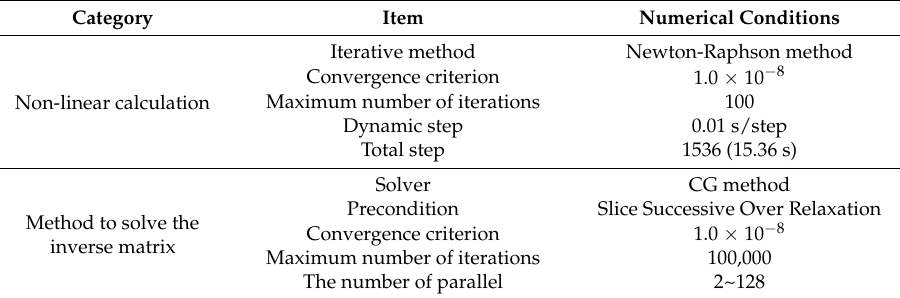
( b ) Figure 13. Shear strain distribution of ZX direction (15.36 s) in ( a ) the original model and ( b ) the proposed model. The excess pore water pressure ratio distribution at the final time step is shown in Figure 14. The proposed model produced slightly higher excess pore pressure than the original model, but the distributions of both models were relatively very similar. For both models, the maximum value of the excess pore water pressure ratio exceeded 0.5. ( a )